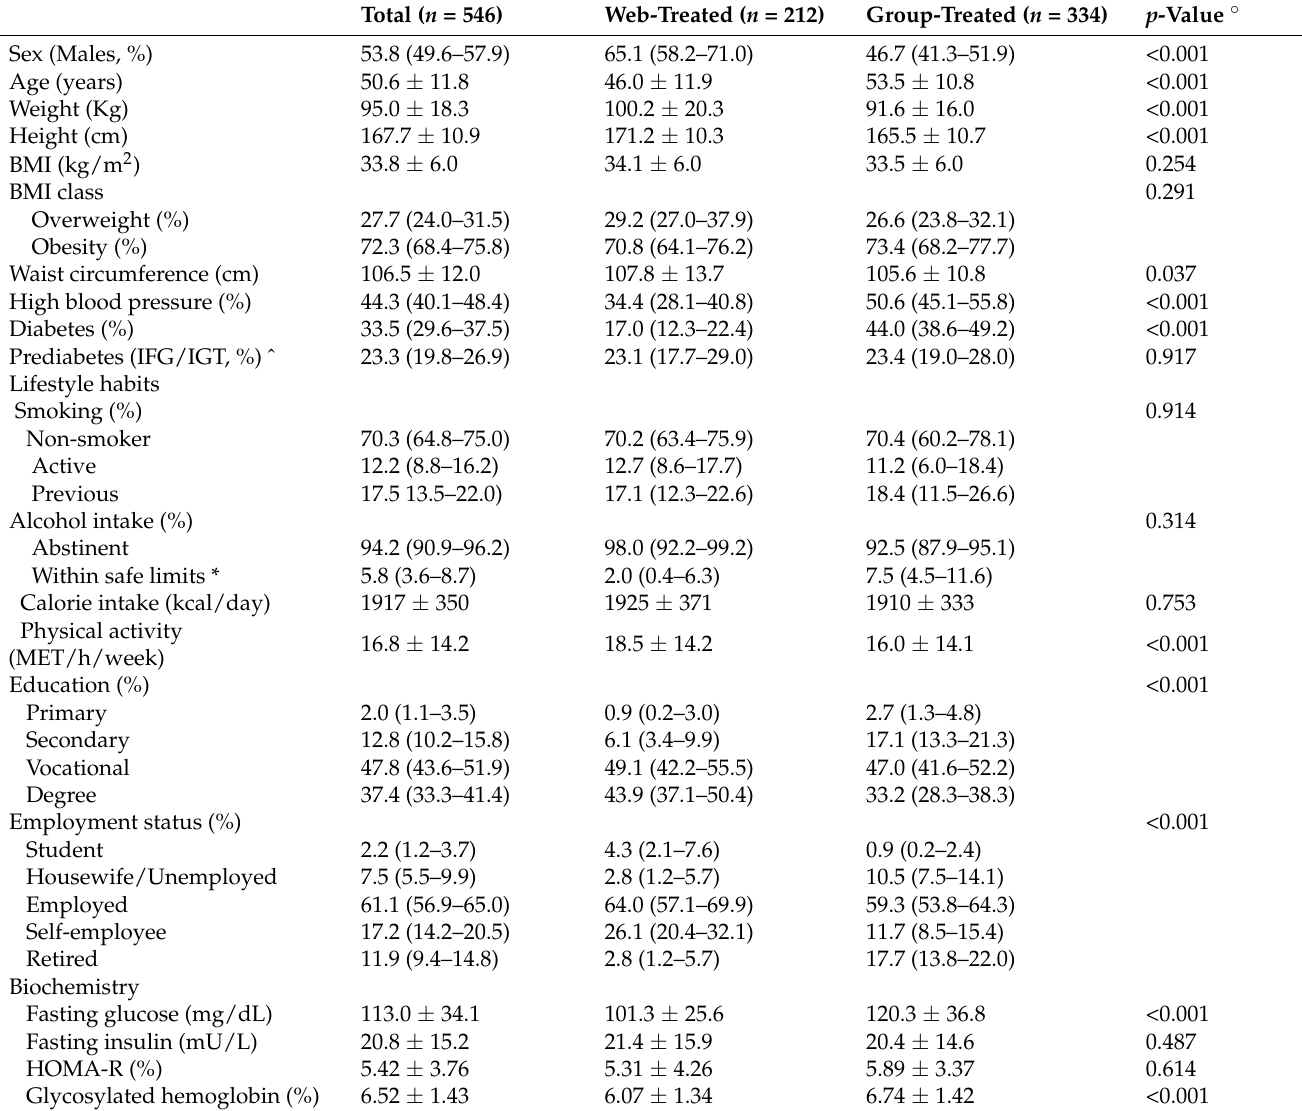
Table 1. Socio-demographic, clinical and biochemical data in the two groups at baseline. Data are presented as means ± SD or as prevalence (95% confidence